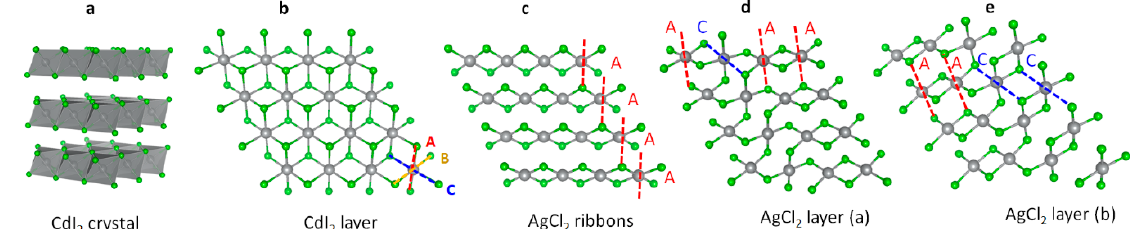
Figure 3. Derivation of the predicted ribbon and layered AgCl 2 polymorphs by orbital ordering of the Jahn-Teller (JT) active dz 2 orbitals in the CdI 2 -type structure. The original CdI 2 structure is shown in ( a ) and the single layer in ( b ). Orientation of the JT orbitals manifests itself by direction of octahedral elongation denoted by red dashed lines. Resulting orbital ordering patterns are also indicated for AgCl 2 ribbons—AAA as shown in ( c ), AgCl 2 layer ( a )—AACAAC as shown in ( d ), and AgCl 2 layer ( b )—AACC as shown in ( e ).